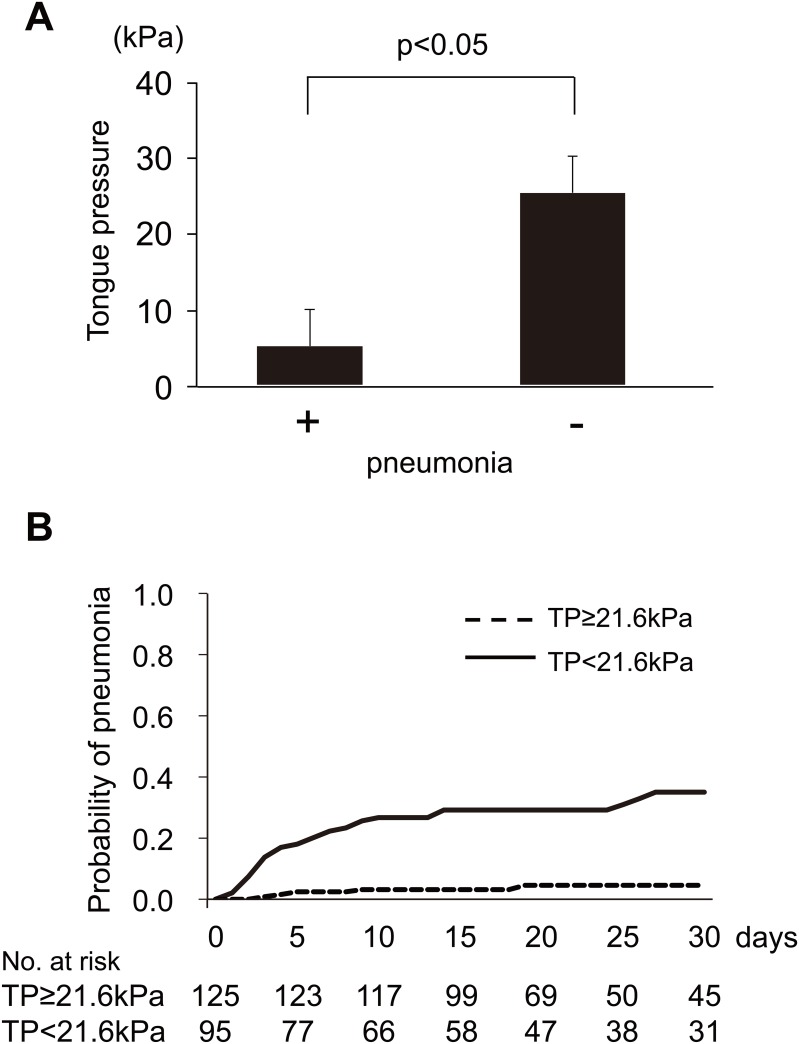
Relationship between tongue pressure and pneumonia.The tongue pressure was significantly lower in patients with pneumonia than in those without pneumonia using unpaired t-tests. The error bars indicate the standard deviation (A). Kaplan–Meier curves of the duration until the development of pneumonia between the high tongue pressure group (≥21.6 kPa) and low tongue pressure group (<21.6 kPa) (B). The low tongue pressure (TP) group had a higher incidence of pneumonia.